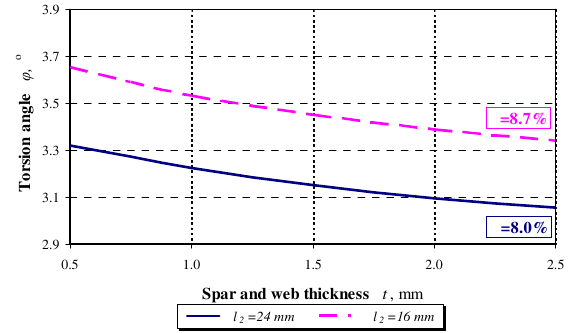
Fig 13. Influence of spar and web thickness on torsion angle